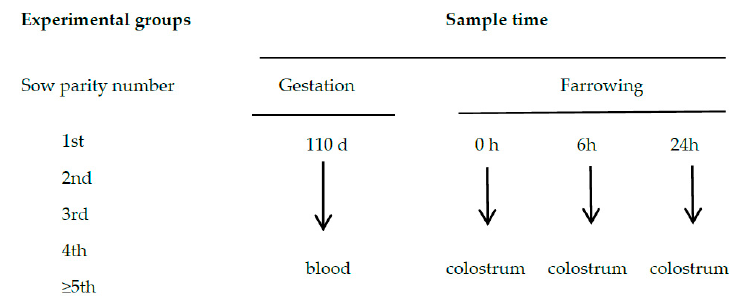
Figure 1. Experimental groups and sampling times for the collection of blood and colostrum .